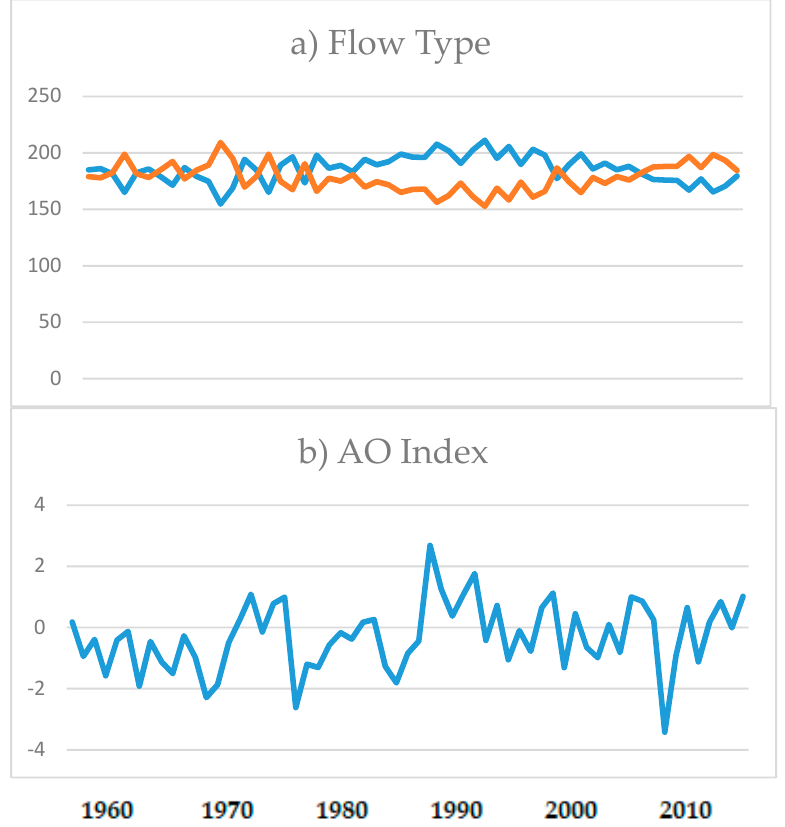
Figure 6. The number of ( a ) NH days with a zonal (Type 1 and 2—blue) and meridional (Type 3 and 4—orange) flow regimes, and ( b ) the winter season NAO Index from 1957–2017 following reference [62].